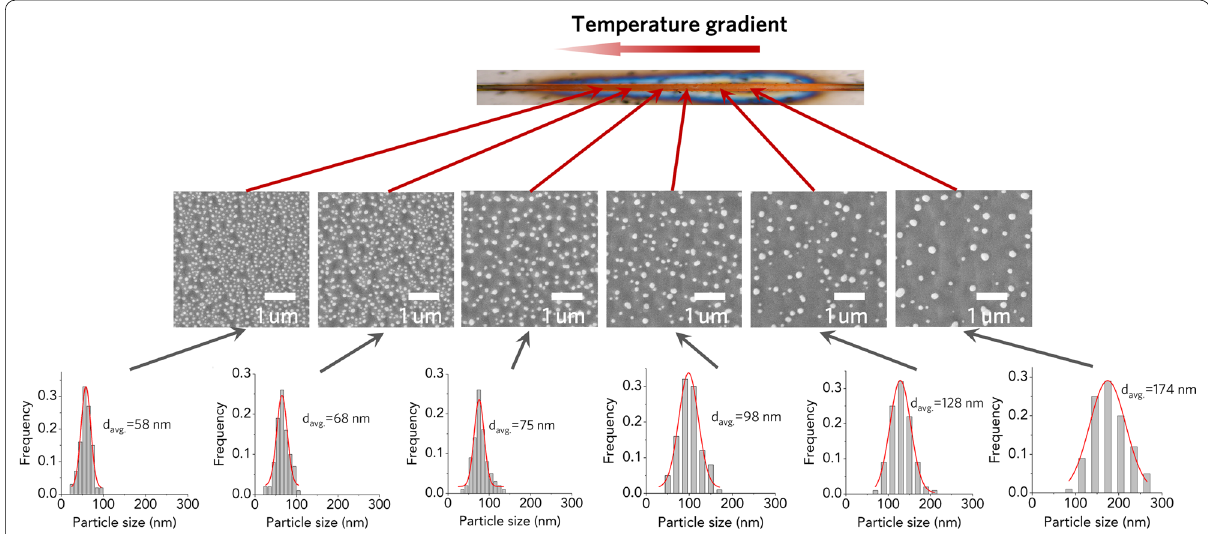
Fig. 4 SEM images of different positions along the microwire after thermal gradient annealing and corresponding size distributions of particles in each